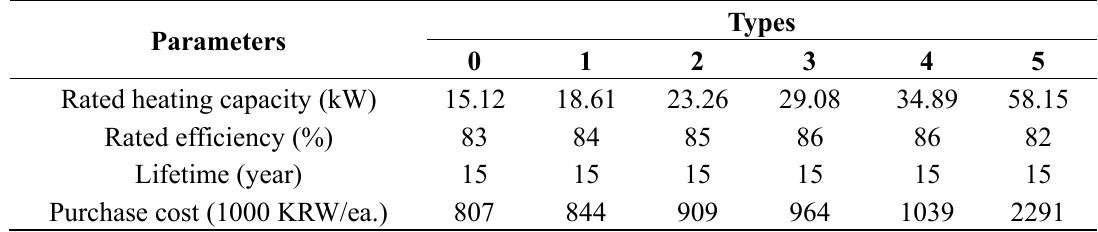
Table A5. Technical and economic parameters of the auxiliary heaters for each case.